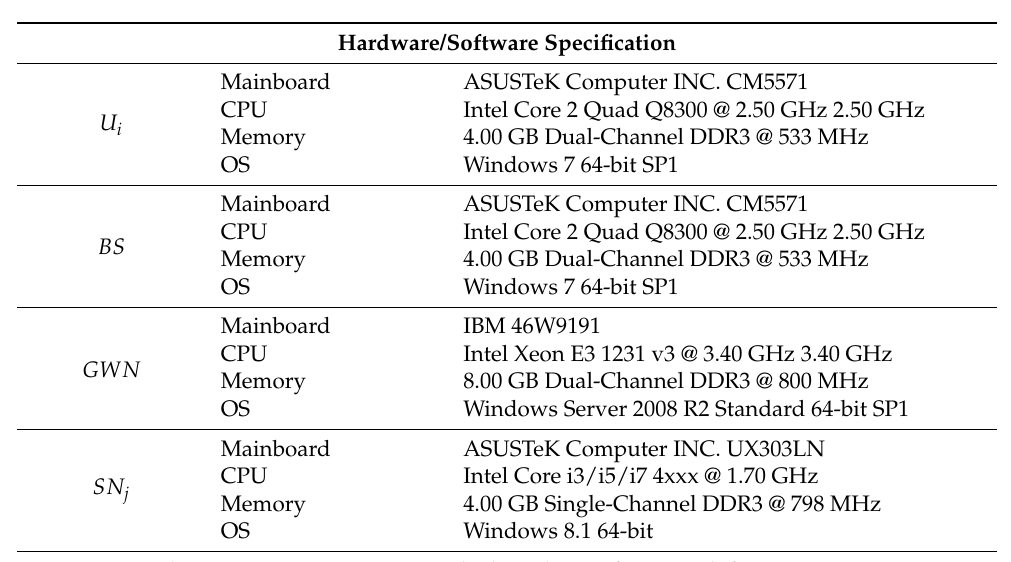
Table 5. Simulation